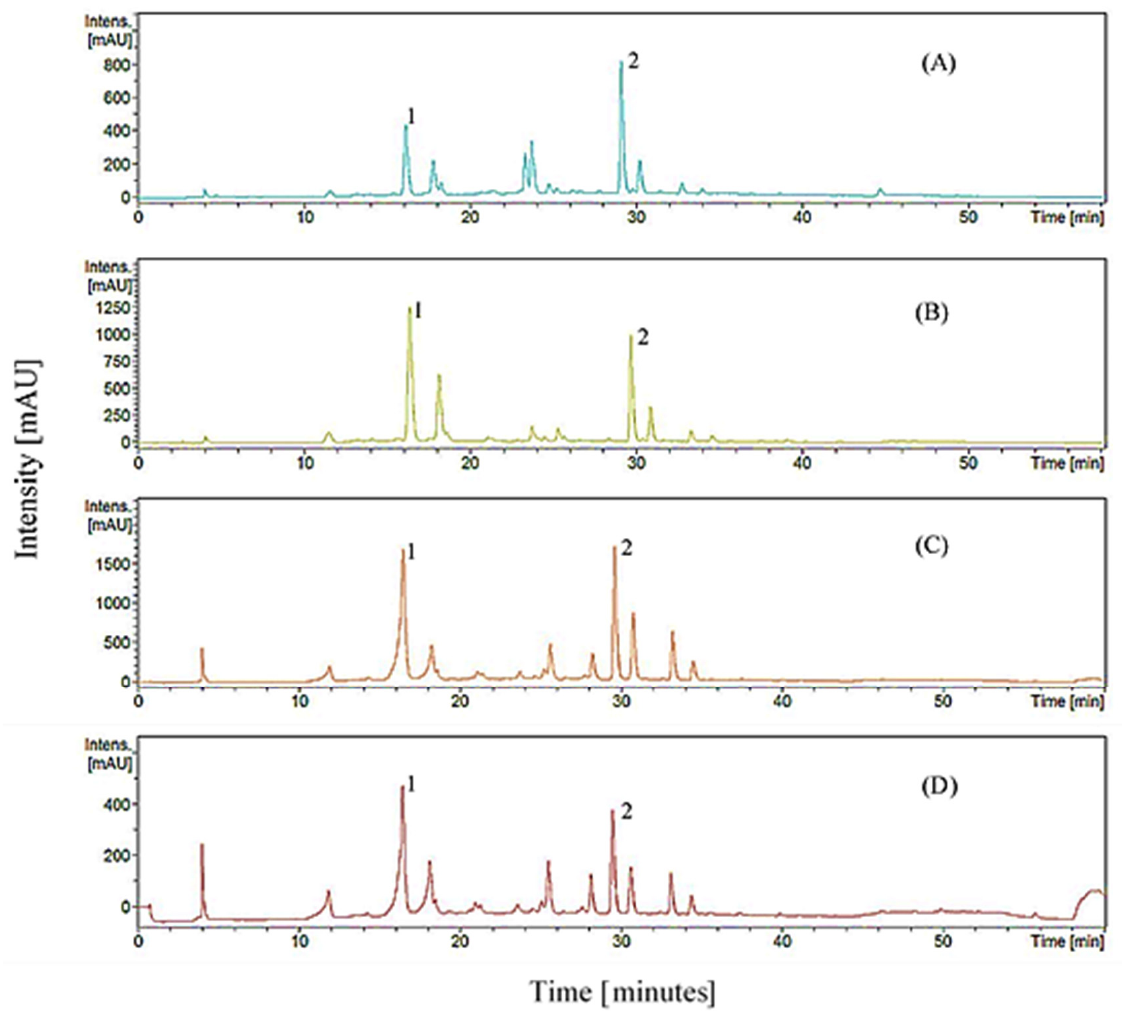
Figure 1. UHPLC chromatograms of mulberry fruits and leaves at different maturities and solvent extracts: ( A ) black fully ripe fruits in 65% ( v / v ) acetone; ( B ) red mature fruits in 65% ( v / v ) acetone; ( C ) young leaves in 60% ( v / v ) ethanol; ( D ) mature leaves in 60% ( v / v ) ethanol. 1, chlorogenic acid; 2, rutin.